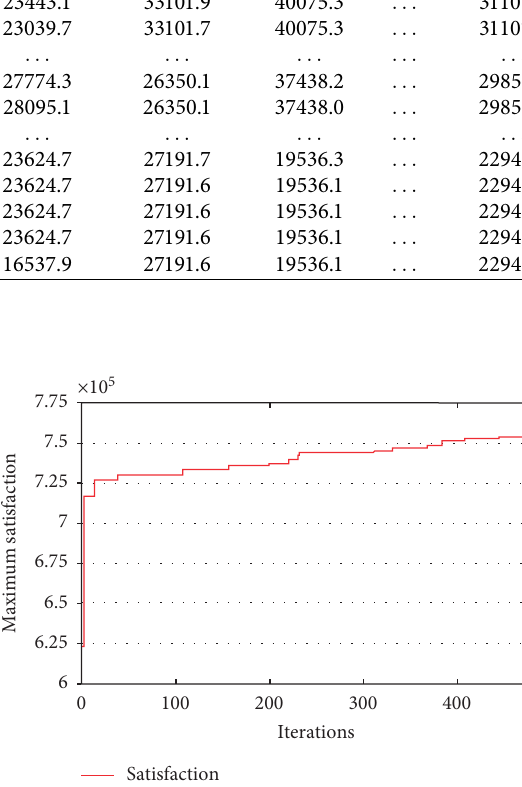
Figure 3: Algorithm iteration result graph with 20 min departure interval.